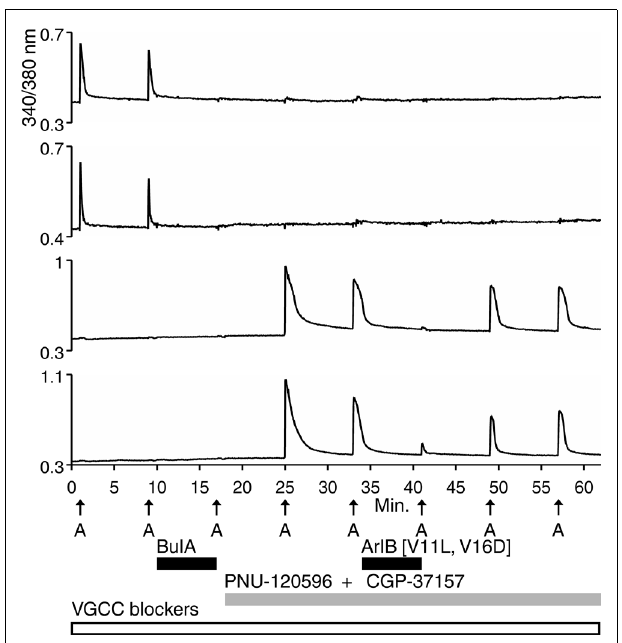
FIGURE 3 | Functional expression of α 7 nAChRs and β 4-containing nAChRs in different mouse DRG neuronal subclasses. Like rat DRG neurons, mouse DRG neurons could be divided into subclasses that express either α 7 nAChRs or β 4-containing nAChRs. Shown are traces of responses from selected neurons in an experimental trial conducted in the presence ofVGCC blockers, as indicated by a long, open horizontal bar.The cocktail ofVGCC blockers consisted of 200 nM ω -conotoxin GVIA to block N-type calcium channels, 200 nM ω -conotoxin MVIIC to block P/Q-type calcium channels, and 1 μ M nicardipine to block L-type calcium channels. This protocol eliminated the shoulders observed for ACh-elicited calcium signals in the β 4-expressing subclass, suggesting that those shoulders were due to activation ofVGCCs.This protocol also confirms that the signals observed are from calcium influx through nAChRs as was the case with rat DRG neurons also (see Figure 2 ). After two ACh pulses, 10 μ M BuIA was applied to the bath as indicated by a short, black horizontal bar. The ACh-responsive neurons were blocked irreversibly by BuIA, as was the case with rat DRG neurons also (see Figure 2 ). After block by BuIA, 5 μ M PNU-120596 (PNU) was applied to the bath solution for the duration of the experiment, as indicated by a long, gray horizontal bar. After application of PNU, ACh pulses revealed a second subclass of DRG neurons that were previously unresponsive to ACh, and that were not blocked irreversibly by BuIA. ACh responses in this second subclass of DRG neurons were blocked reversibly by 200 nM ArIB[V11L;V16D], similar to rat DRG neurons (see Figure 2 ). Because the broad shoulders of peaks persisted in the PNU-elicited ACh responses in the presence ofVGCC blockers (see Figure 2 ), we applied PNU in combination with the blocker of